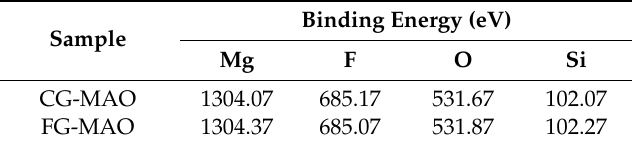
Table 1. The binding energy of main elements of CG-MAO coating and FG-MAO coating. Sample